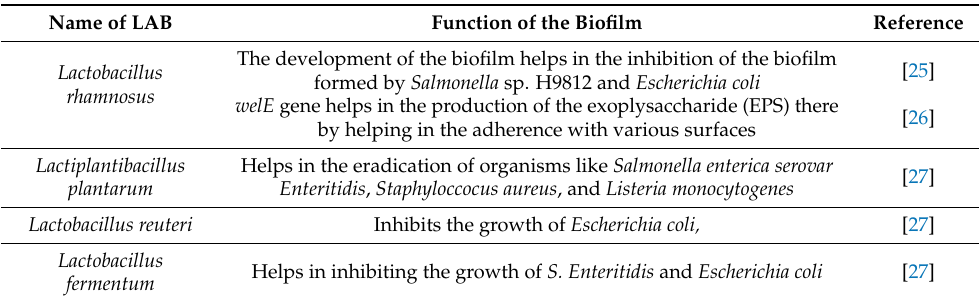
Table 1. Biofilm development by LAB.